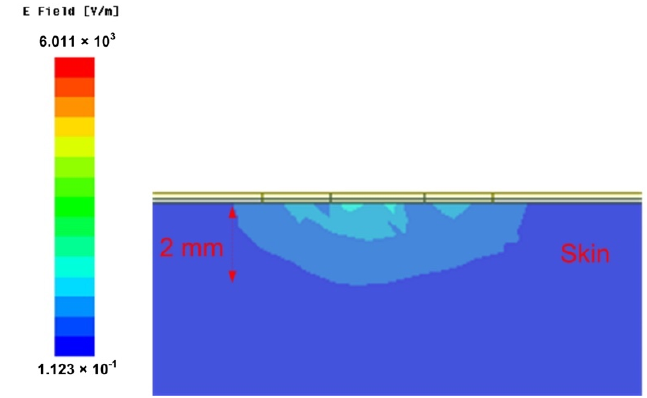
Figure 7. The penetration depth of sensor.